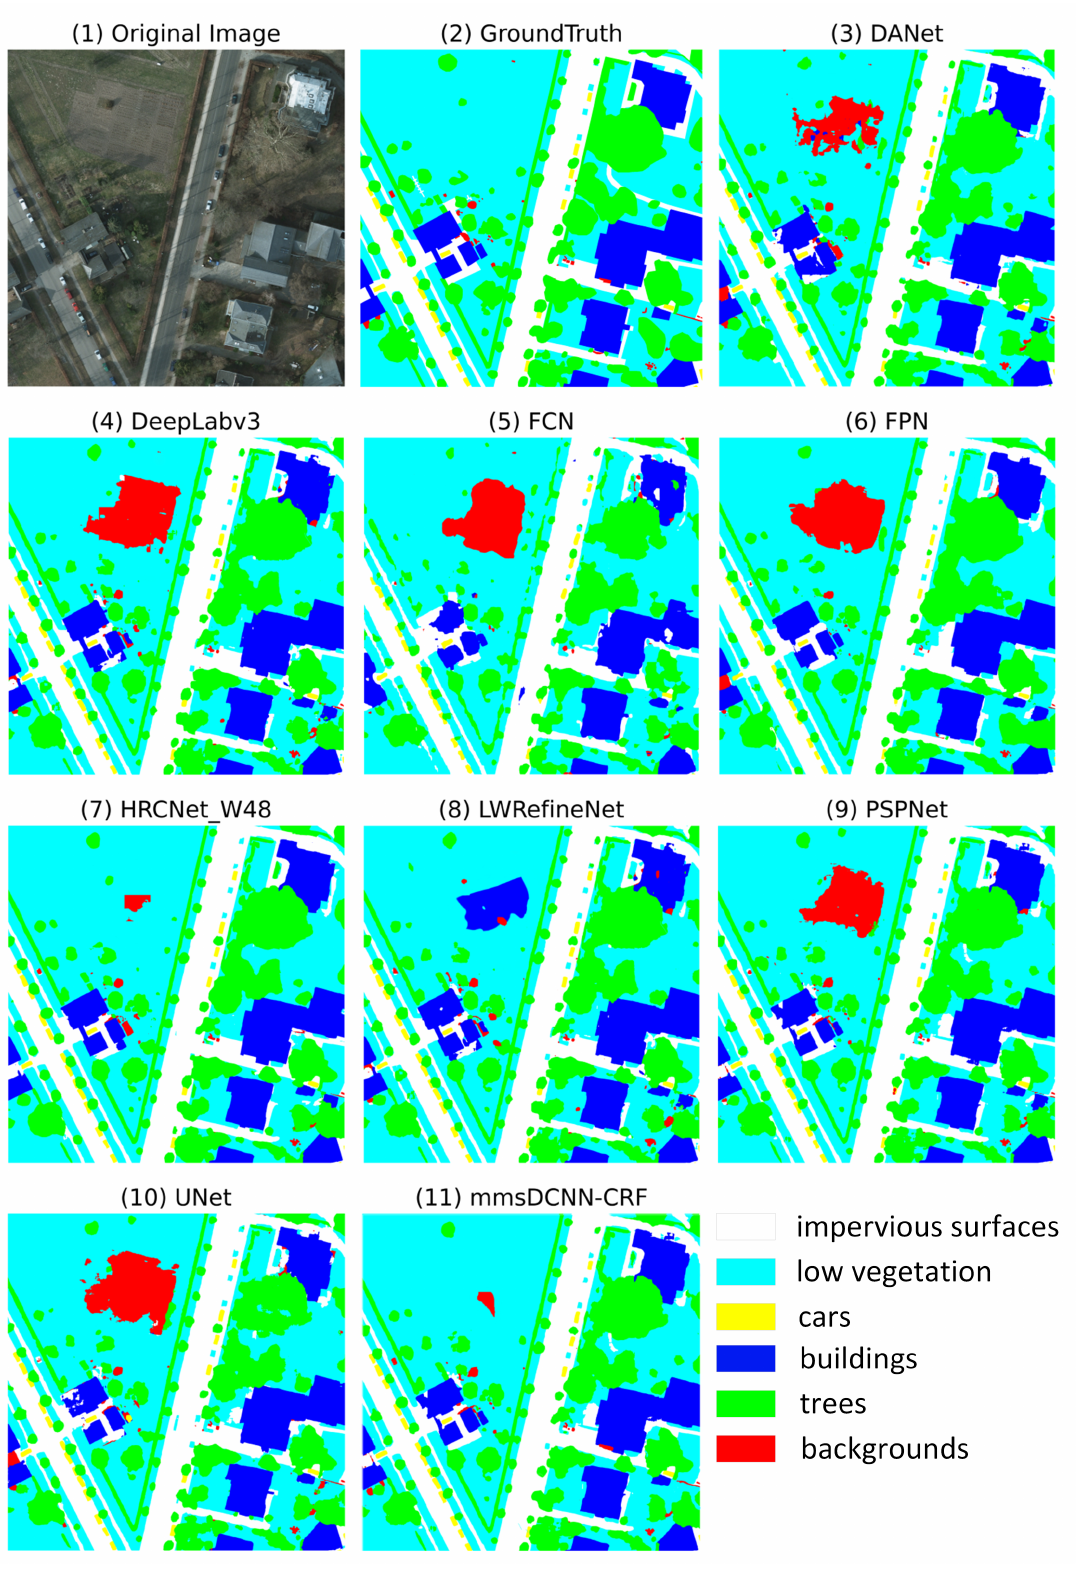
Figure 7. The figure shows the experimental results of all experimental models and the ground truth on the Potsdam